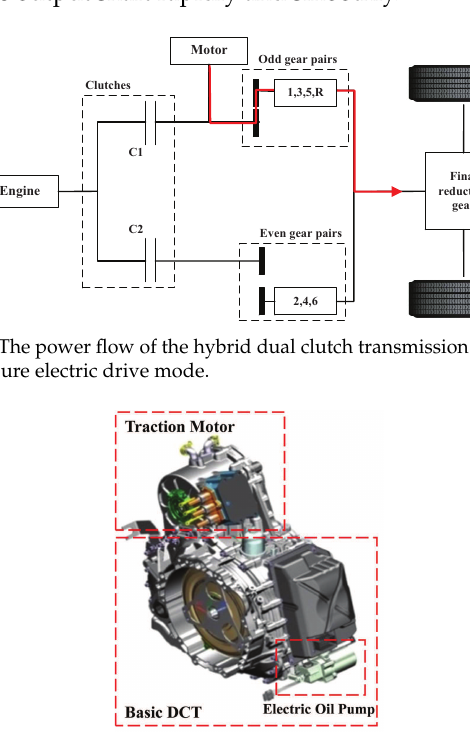
( b ) The 3-D model of the hybrid DCT gearbox. Figure 1. Schematic of the hybrid DCT powertrain system. ( a ) The power flow of the hybrid DCT in pure electric drive mode;